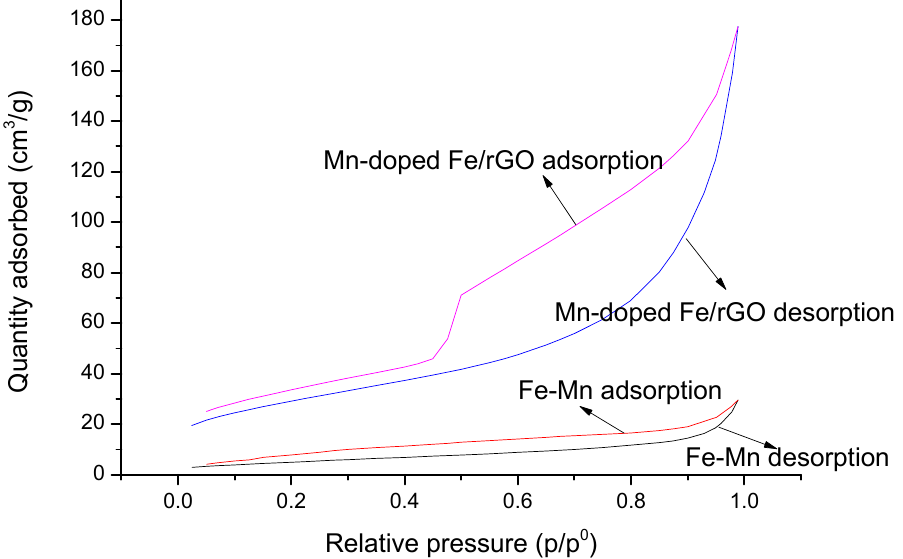
Figure 10. Nitrogen adsorption–desorption isotherm of Fe–Mn and Mn-doped Fe/rGO.